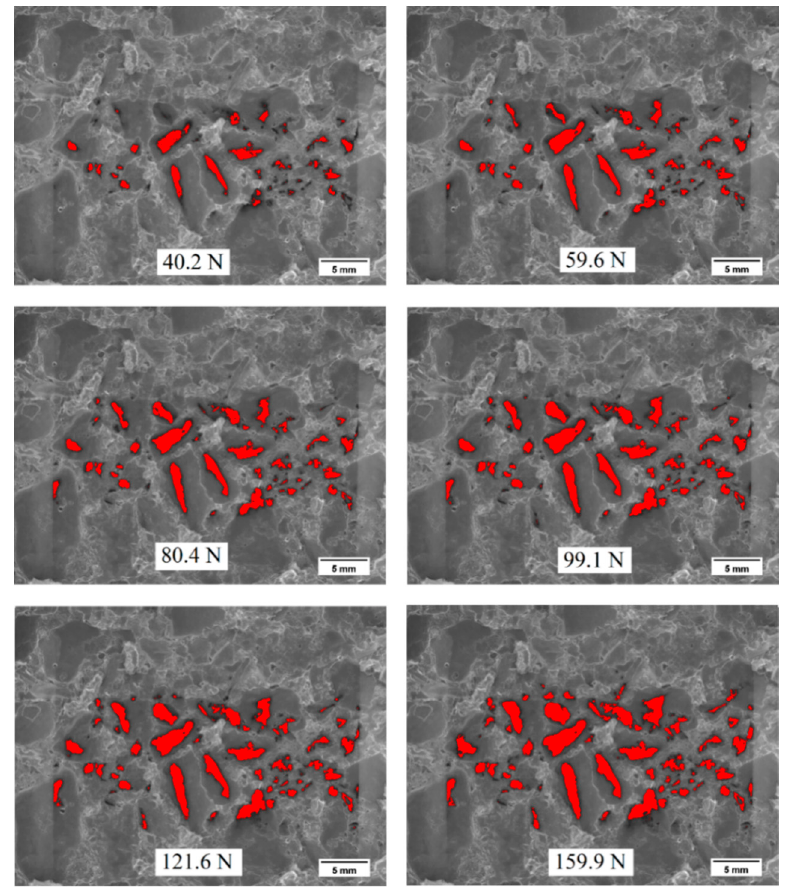
Figure 8. Fluorescence images of rubber-wheel contact due to applied normal loads .